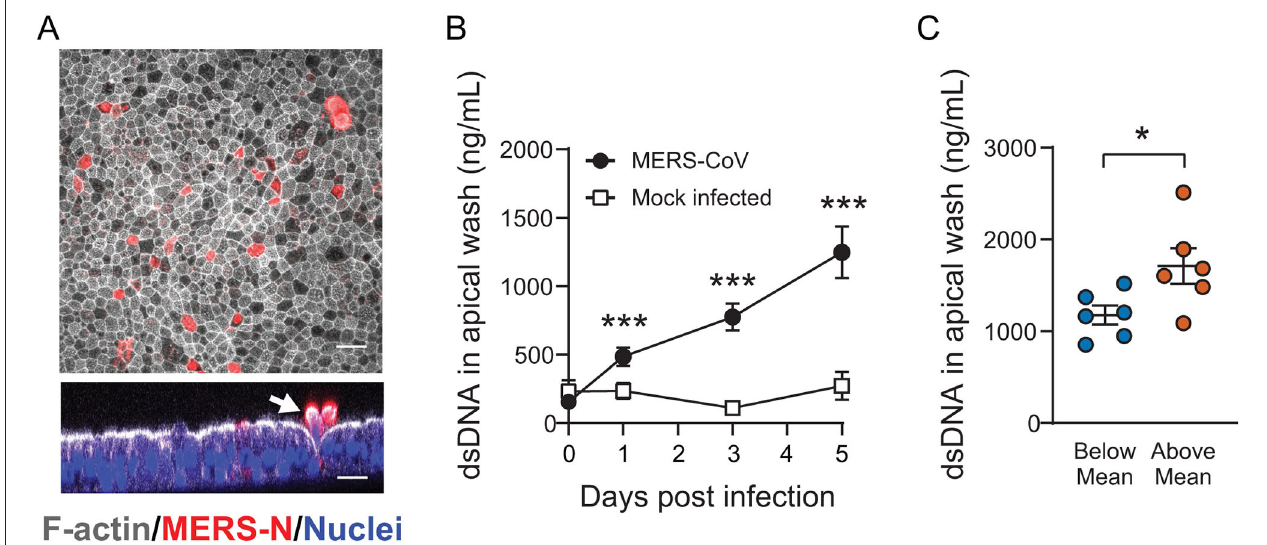
FIGURE 4 | The impact of cellular DPP4 abundance on MERS-CoV induced airway epithelial sloughing. (A) Following MERS-CoV infection (MOI = 0.1), HAE were fixed and stained with anti-MERS N protein antibody, phalloidin, and DAPI to identify infected cells (red), filamentous actin (white), and nuclei (blue), respectively. In the cross sectional image, infected cells are seen being expelled from the epithelial surface (white) at 4 days post infection (arrow). Scale bar = 20 µ m. (B) To test for shed cells, the apical compartments of MERS-CoV infected cultures ( n = 10) or mock infected cultures ( n = 3) were sampled by rinsing with PBS and the abundance of cellular genomic DNA was measured in the collected material at the indicated time points. For both groups, data were tested for significant increases in shed DNA relative to baseline (Day 0) by repeated measures one-way ANOVA followed by Tukey’s multiple comparisons test *** P Adj < 0.001. (C) The abundance of cellular genomic DNA in apical washes was compared for HAE with Above-Mean or Below-Mean DPP4 expression at 5 days post infection ( n = 6 for both groups). The groups were tested for significant differences by unpaired 2-tailed t -test * P < 0.05. In (B,C) , data are plotted as mean ±